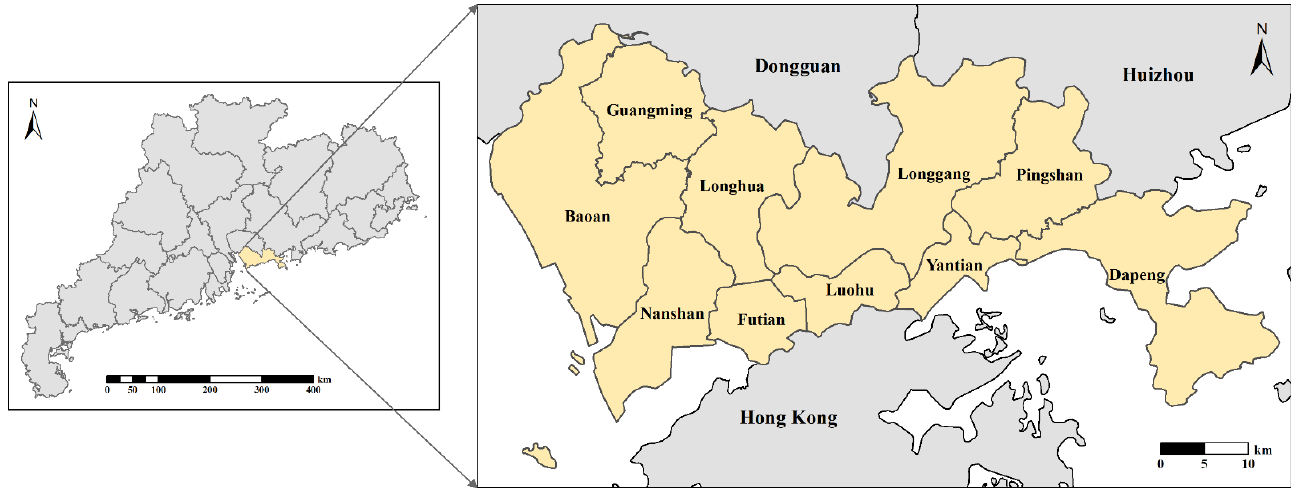
Figure 1. Case study area: Shenzhen, Guangdong Province, China. Table 1. List of data used in this study.